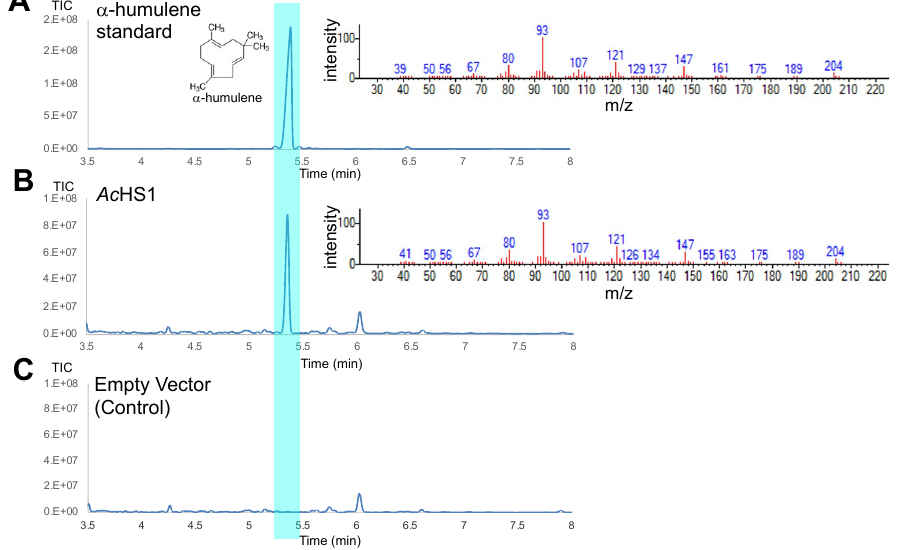
Figure 5. Total ion chromatograms (left panel) and mass spectra (right panel) obtained from GC-MS 353 analysis of an authentic standard for a -humulene ( A ) and dodecane samples from the cultivation of 354 strains FPPY005_39850 harboring pRSII426-Gal1/10-AsSesTPS1 ( B ) and FPPY005_39850 harboring 355 the empty vector pRSII426-Gal1/10 ( C ).